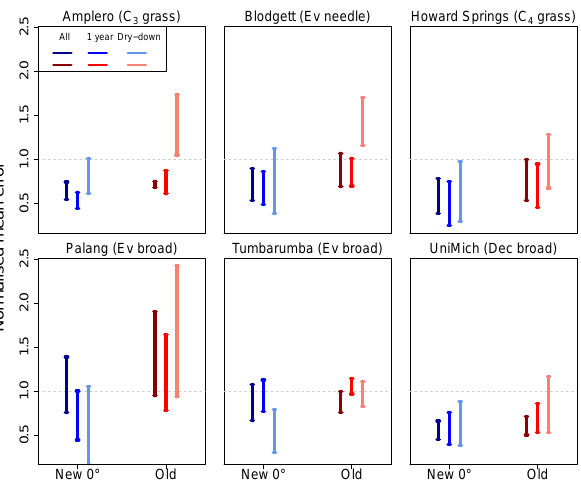
Figure 4. The range in mean bias error metrics of latent heat simulations using the default (red) and new (blue) hydrological schemes with alternative LAI, g s and soil parameterisations dur- ing the whole, annual and dry-down periods. Values closer to 0.0 indicate better model